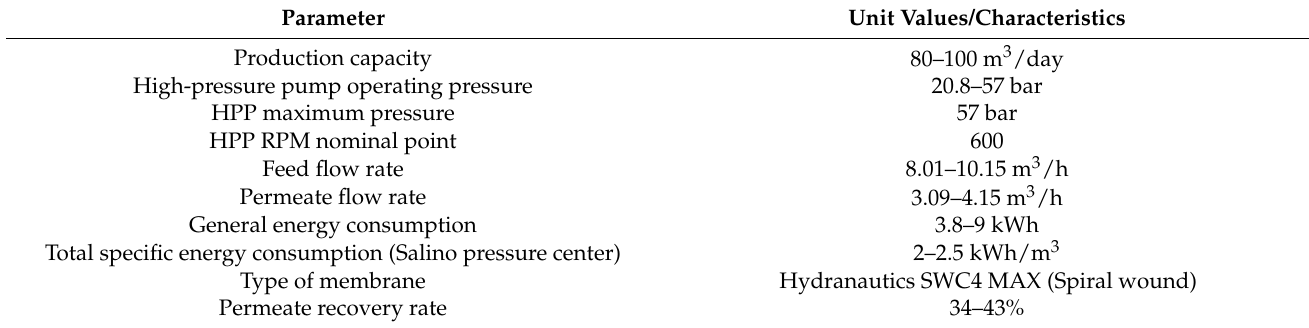
Figure 2. Interior view of the pilot plant used in the study.